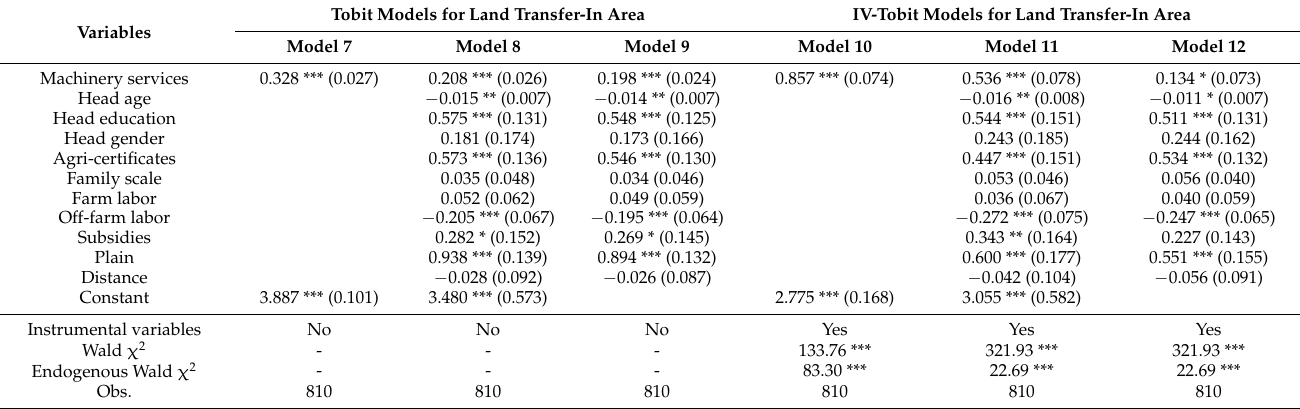
Table 4. The impact of agricultural machinery services on farmers’ land transfer-in area.